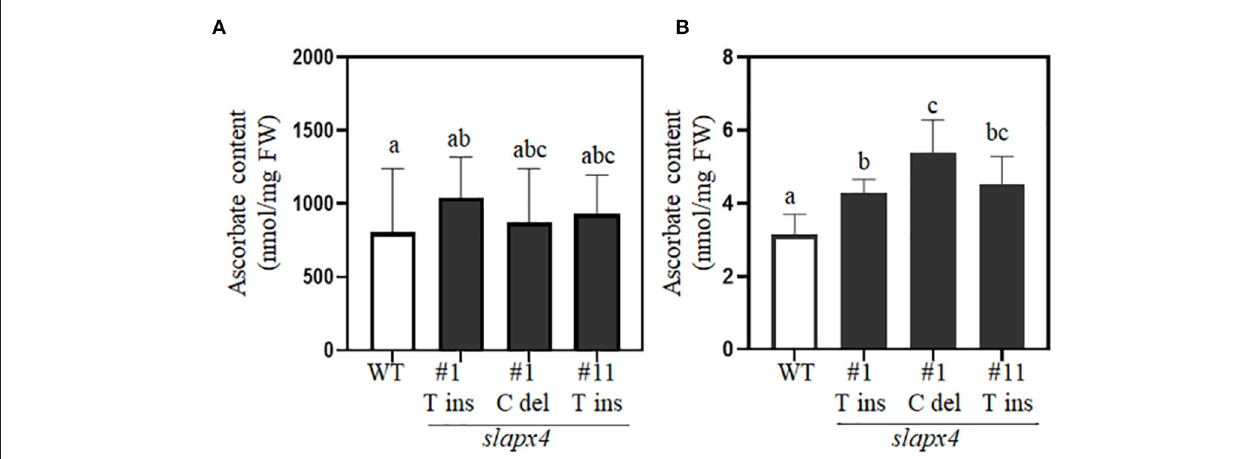
FIGURE 3 | Determination of ascorbate content in SLAPX4 mutant plants. (A,B) Wild-type (WT) and SLAPX4 mutant plants containing biallelic mutation (T base insertion; SLAPX4 #1T ins and #11T ins, C base deletion; SLAPX4 #1C del) were grown in the soil. The plants were used for quantification of ascorbate content (nmol per fresh weight) in leaves (A) and red-ripening fruits (B) . Leaves and fruits from three independent plants were pooled for ascorbate quantification. Data represent the mean value + SD of three biological replicates. A significant difference was shown with different letters above the bars (one-way ANOVA test). FW, fresh